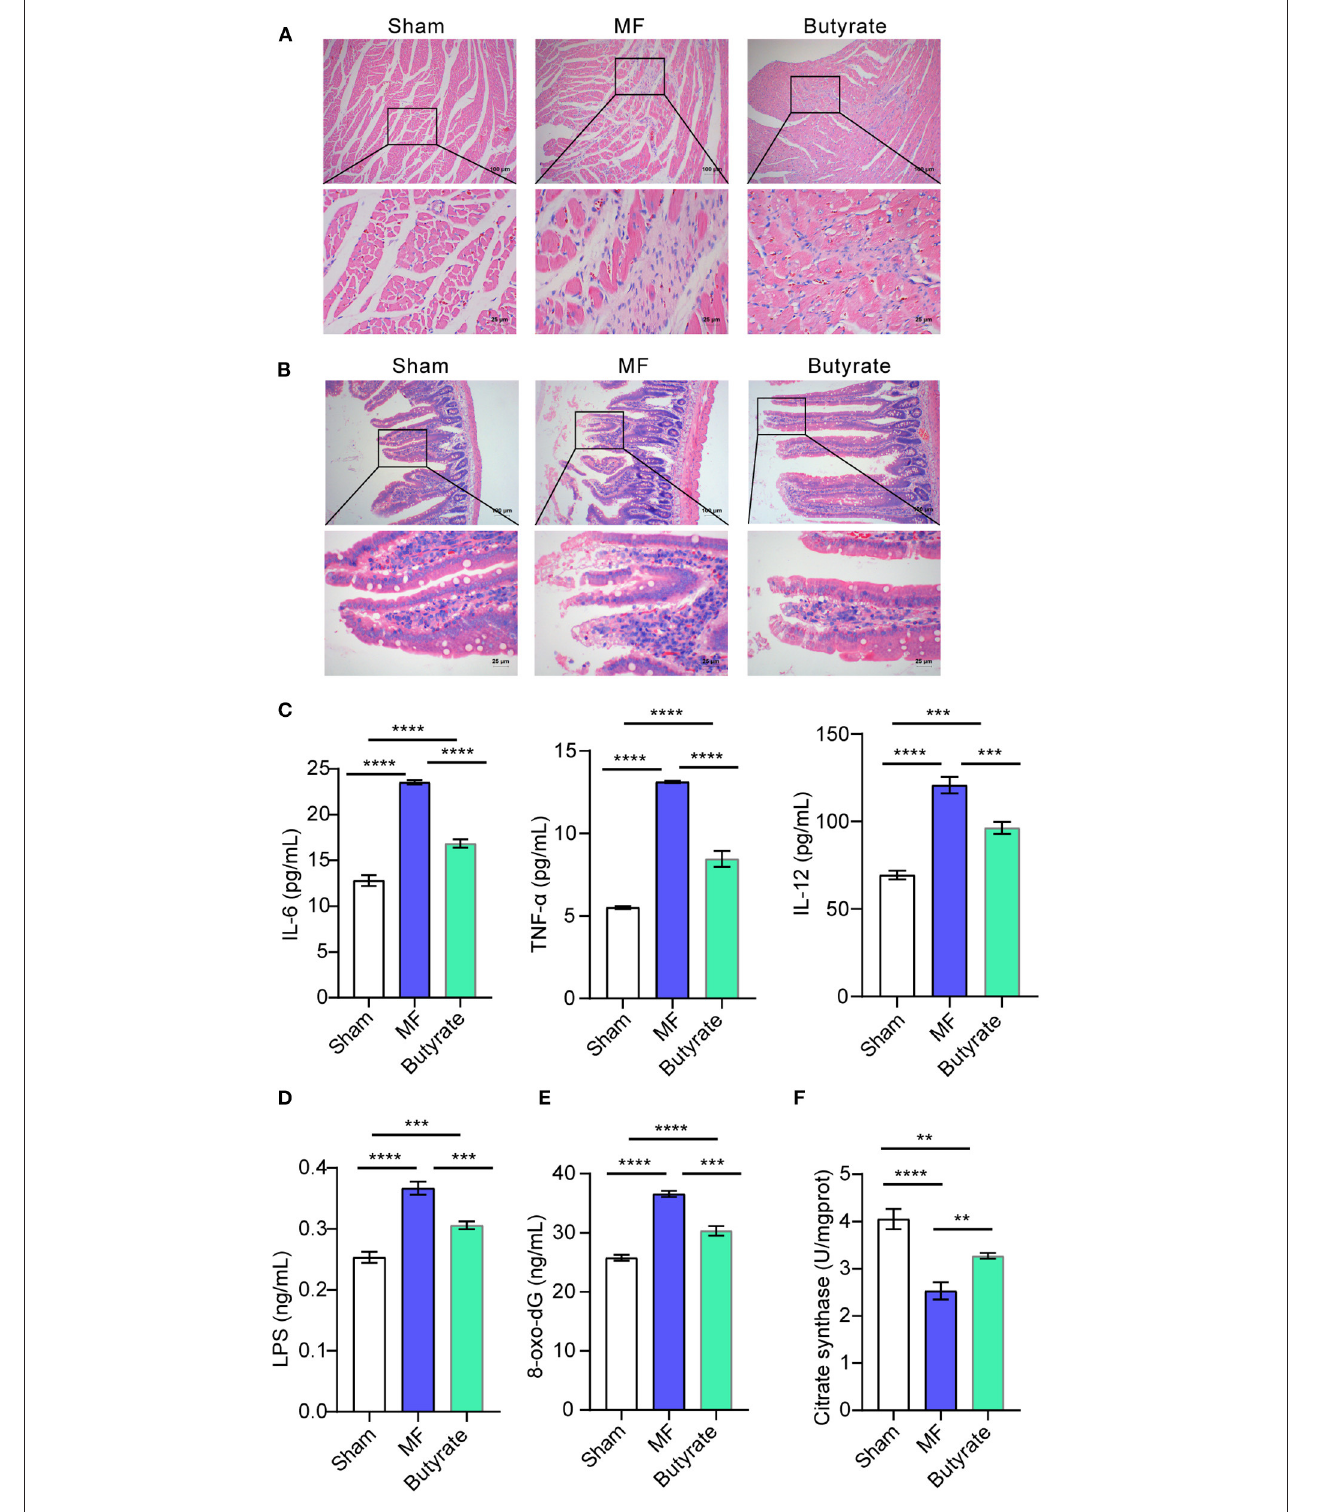
FIGURE 6 | Butyric acid ameliorated symptoms of MF in rats. (A) HE staining was applied to stain the heart tissues. (B) . HE staining was performed to stain the gut tissues. (C) The levels of IL-6, TNF- α , and IL-12 in plasma were determined by ELISA. (D–F) . ELISA was used to detect the levels of LPS, 8-oxo-dG and CS. ** P < 0.01, *** P < 0.001, **** P < 0.0001.